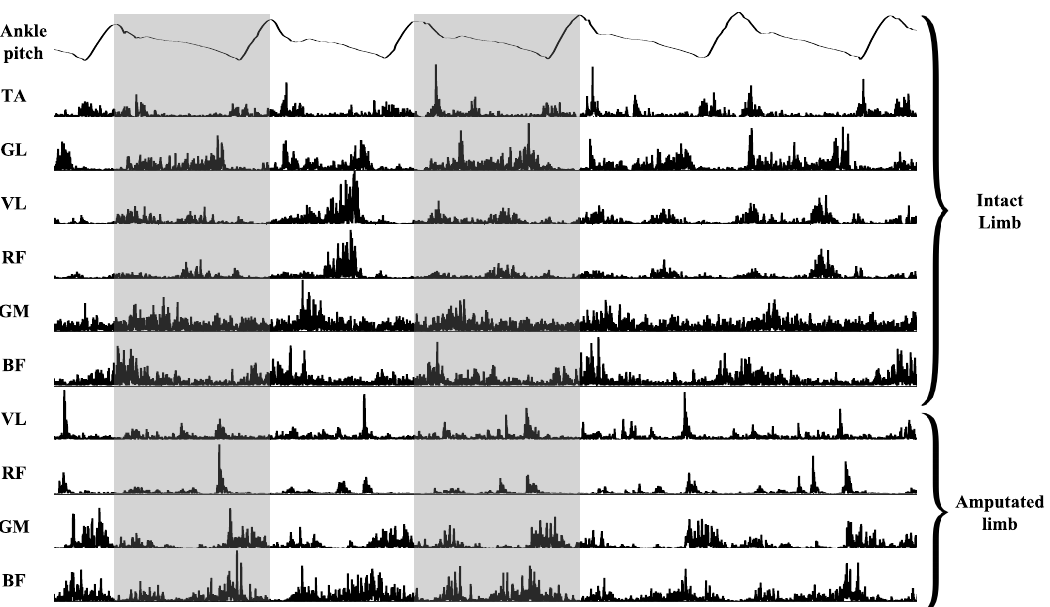
Figure 2. 10 channels of EMG from lower limb of BK1 while operating PPA with zero percent power and zero percent stiffness for five steps. The pitch signals depicted on top was used to detect each step and it was used to partition EMG signals to each step. Two steps detected from the pitch signals are highlighted.